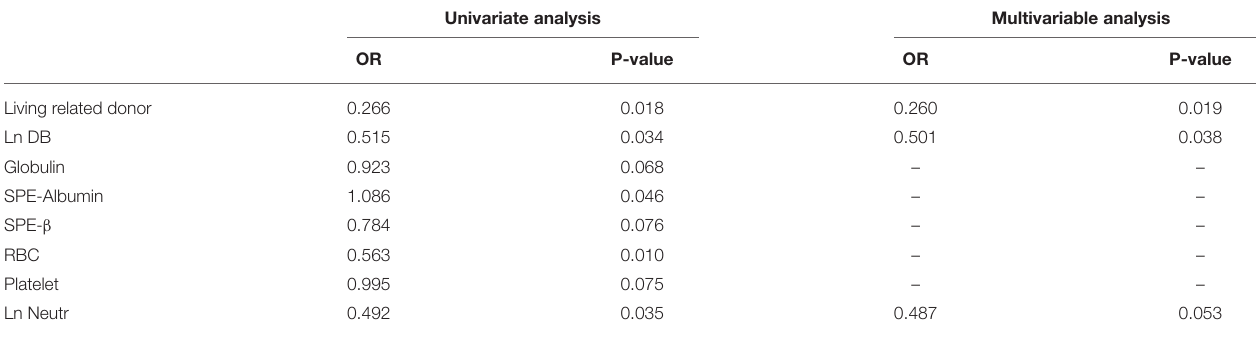
TABLE 2 | The multivariate logistic regression models for renal transplant recipients (RTRs) with BKV activation.